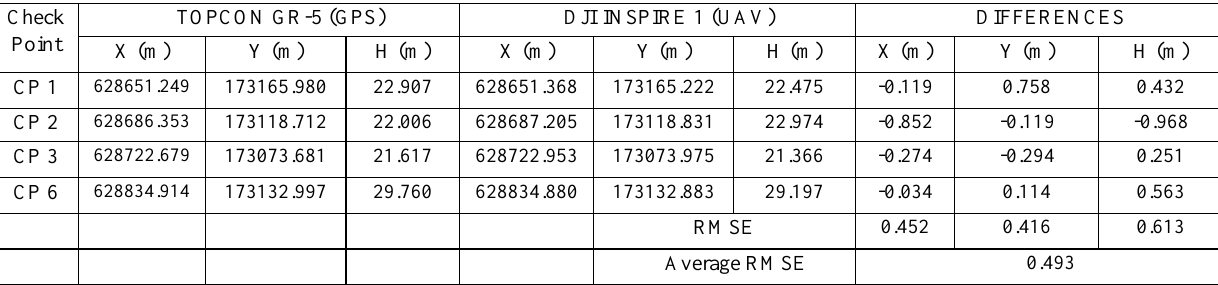
Table 5. Accuracy Assessment for Check Points at 40m Altitude